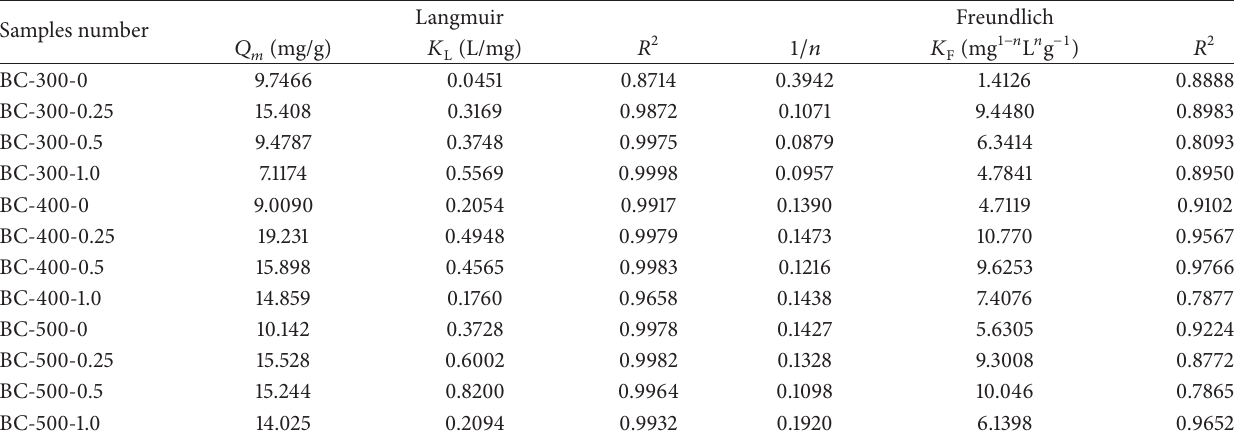
Table 2: Langmuir and Freundlich constants related to the adsorption isotherms of Ni(II) for the BCs samples. Samples